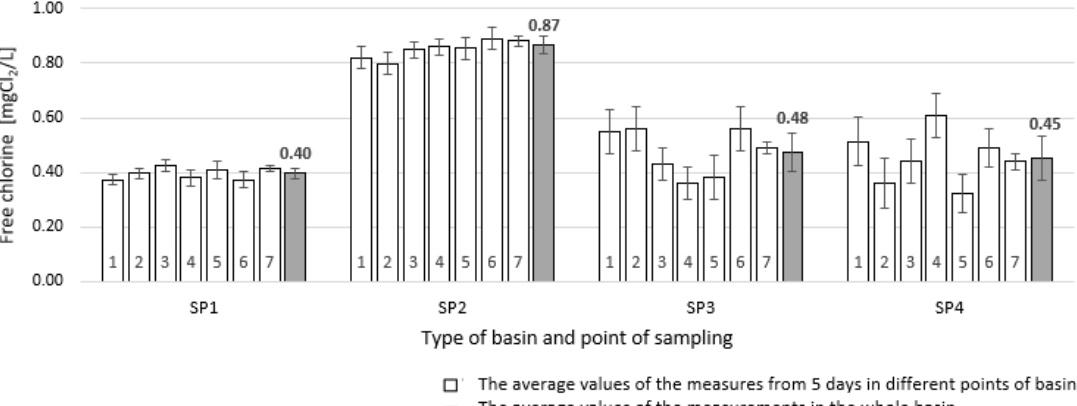
Figure 3. The distribution of free chlorine in the selected points of the basins. Water 2020 , 12 , x FOR PEER REVIEW